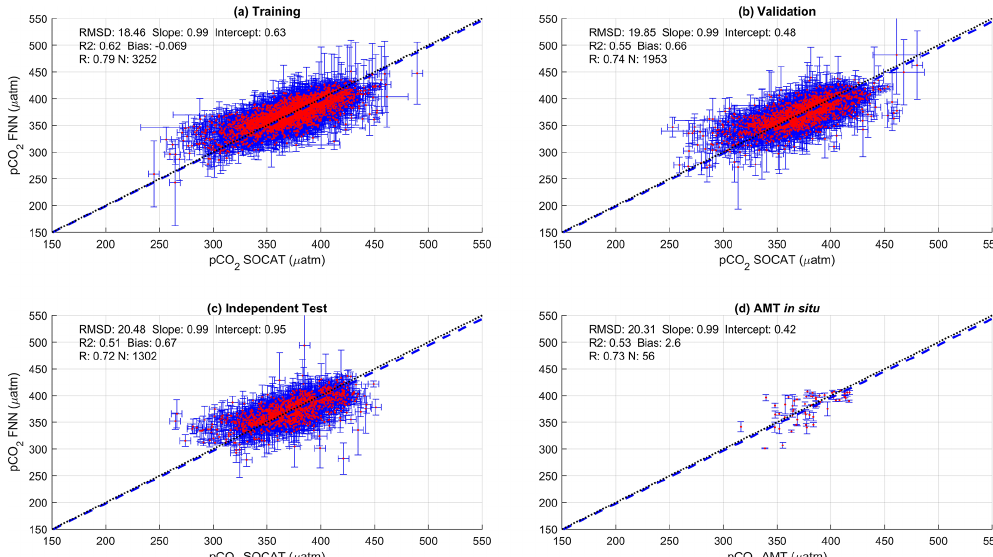
Figure A2. Scatter plots showing the combined performance of the eight feed forward neural networks trained using net primary production for four separate training and validation datasets: (a) training, (b) validation, (c) independent test and (d) Atlantic Meridional Transect (AMT) in situ. The blue dashed line is the type II regression, and the black dashed line is the 1 : 1 line. Horizontal error bars indicate the uncertainty of the SOCATv2020 p CO 2 ( sw ) . Vertical error bars indicate the resulting uncertainty attributed to the input parameter uncertainty propagated through the feed forward neural networks. The statistics within each plot are the root mean square difference (RMSD), slope and intercept of the type II regression, coefficient of determination ( R 2 ), Pearson correlation coefficient ( R ), bias and number of samples ( N ).